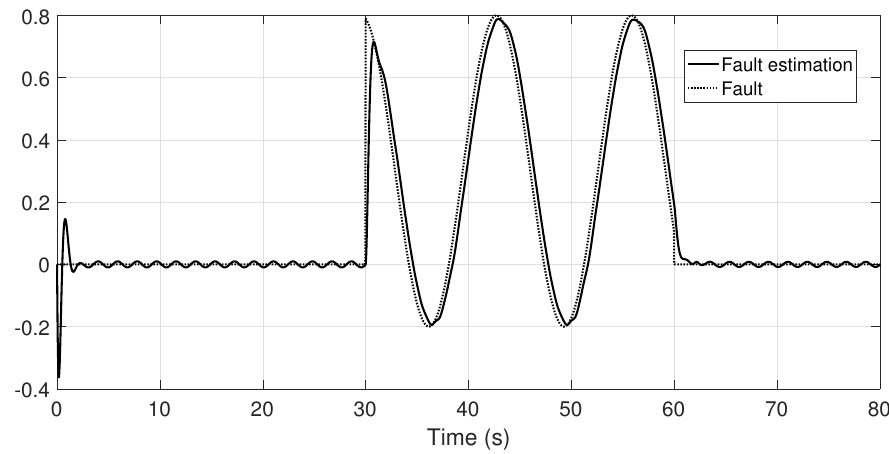
Figure 6. Numerical experiments: Fault estimation and the true actuator